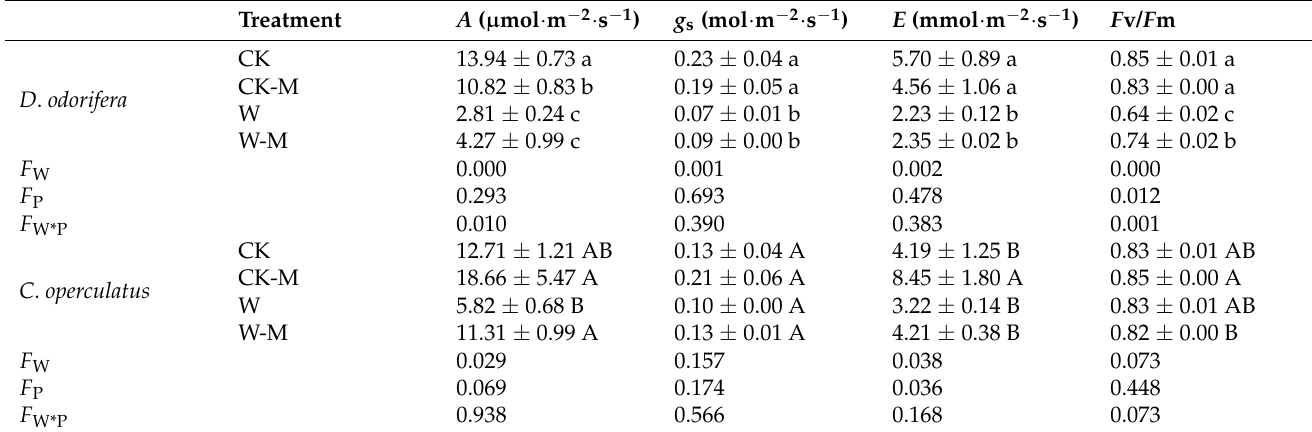
Table 1. Comparative analyses of the parameters of gas exchange and chlorophyll fluorescence of C . operculatus and D . odorifera under all treatments.